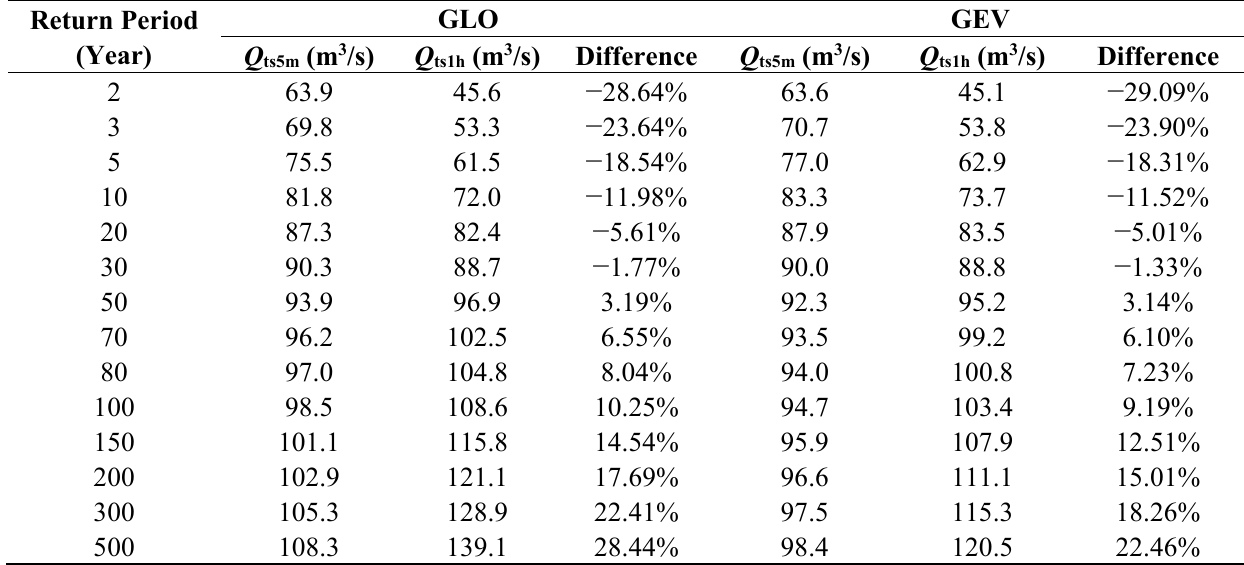
Table 8. The estimated flood quantiles and differences for the GLO and GEV distributions based on time step orders of 5 min and 1 h.